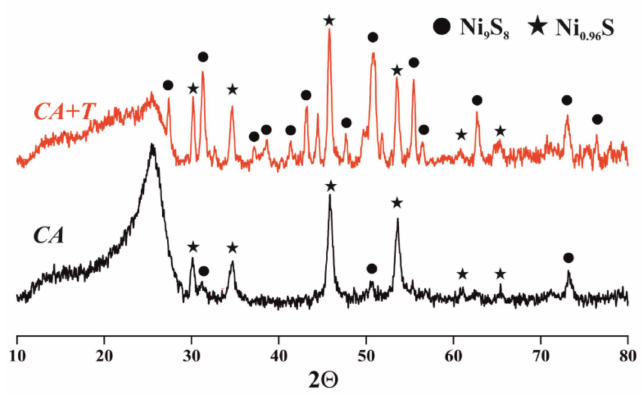
Figure 3. X-ray diffraction patterns of coke-containing